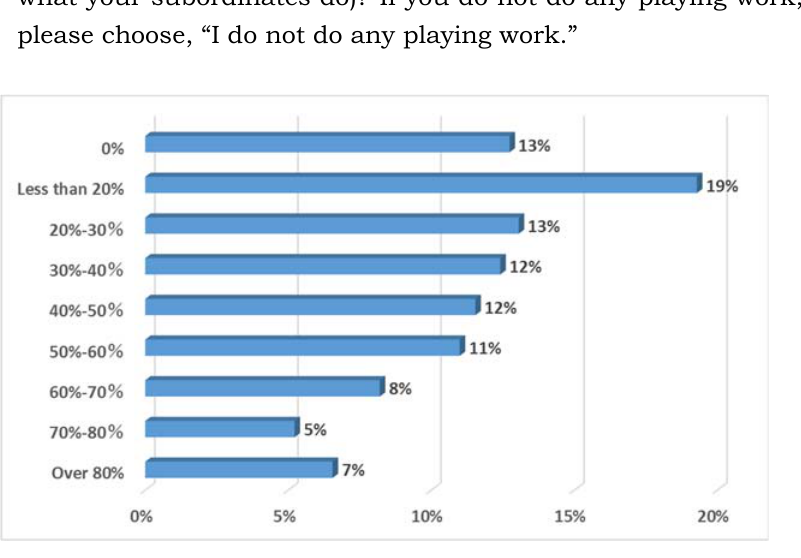
Figure 1. Proportion of non-managerial